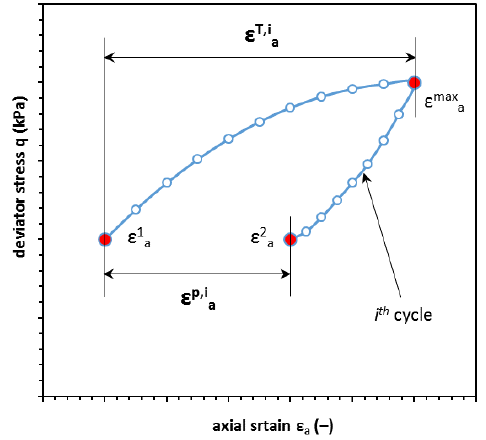
Figure 4. Schema for abation parameter A x parameters calculation.